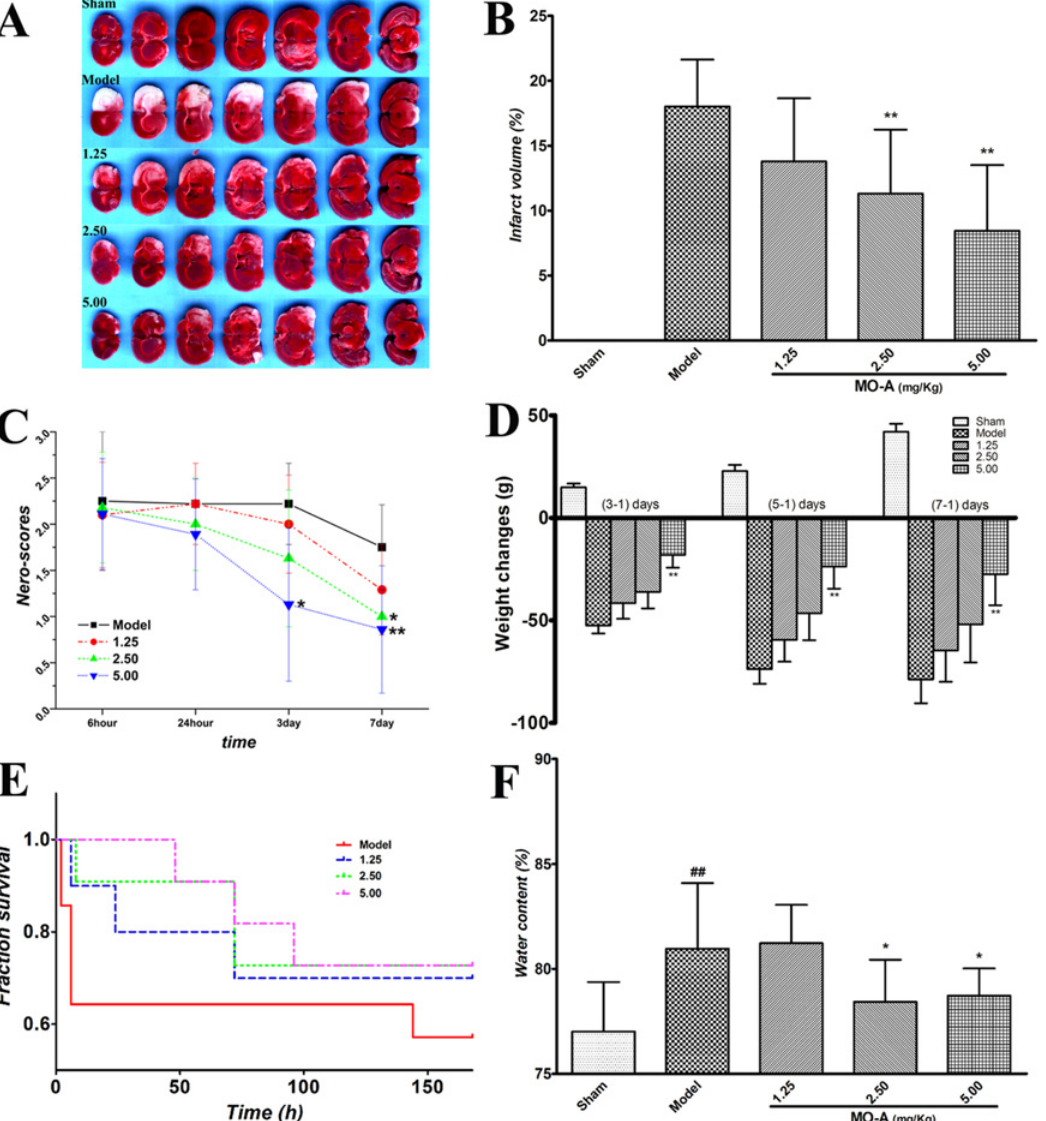
Fig 2. MO-A protects against cerebral injury after MCAO in rats. (A) Infarct images using TTC staining at day 7 after MCAO; (B) Determination of infarct volume at day7 after MCAO (n: sham = 14, model = 9, MO-A 1.25mg/Kg group = 8, 2.50 mg/Kg group = 7, 5.00 mg/Kg group = 8); (C) Neurological deficit was evaluated using a five-point scale (n = 6 – 14); (D) The changes of animal body weights at day 3, 5 and 7, subtracted the body weights of day 1 (n = 6 – 14); (E) Animal survival times, rats were examined once every 3 hours at day 1 and once every 12 hours at day 2 to day 7 (n = 6 – 14). “ Low mobility ” and “ animals incapable of feeding ” were used as humane endpoints; (F) Determination of brain water contents in transient MCAO rats (n = 6 – 14); Data are given as mean ± S.D.; # P < 0.05 and ## P < 0.01 vs . sham group by Student ’ s t -test statistical analysis; * P < 0.05 and ** P < 0.01 vs . MCAO model group by